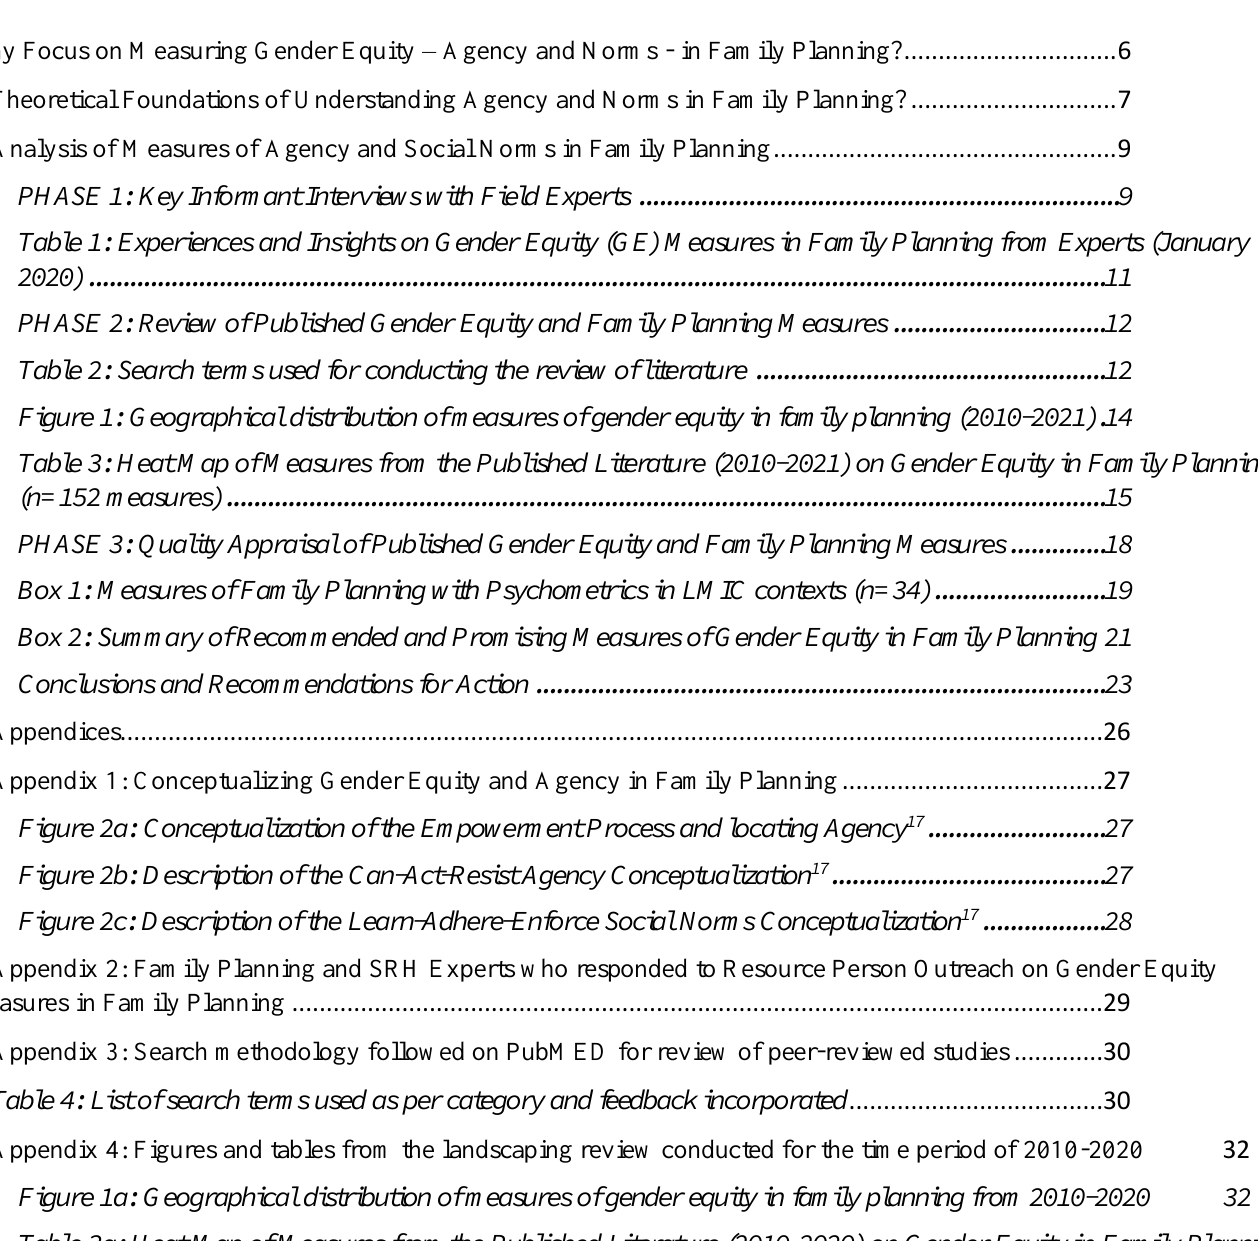
Table 4: List of search terms used as per category and feedback incorporated .....................................30 Figure 1a: Geographical distribution of measures of gender equity in family planning from 2010-2020 Table 3a: Heat Map of Measures from the Published Literature (2010-2020) on Gender Equity in Family Planning